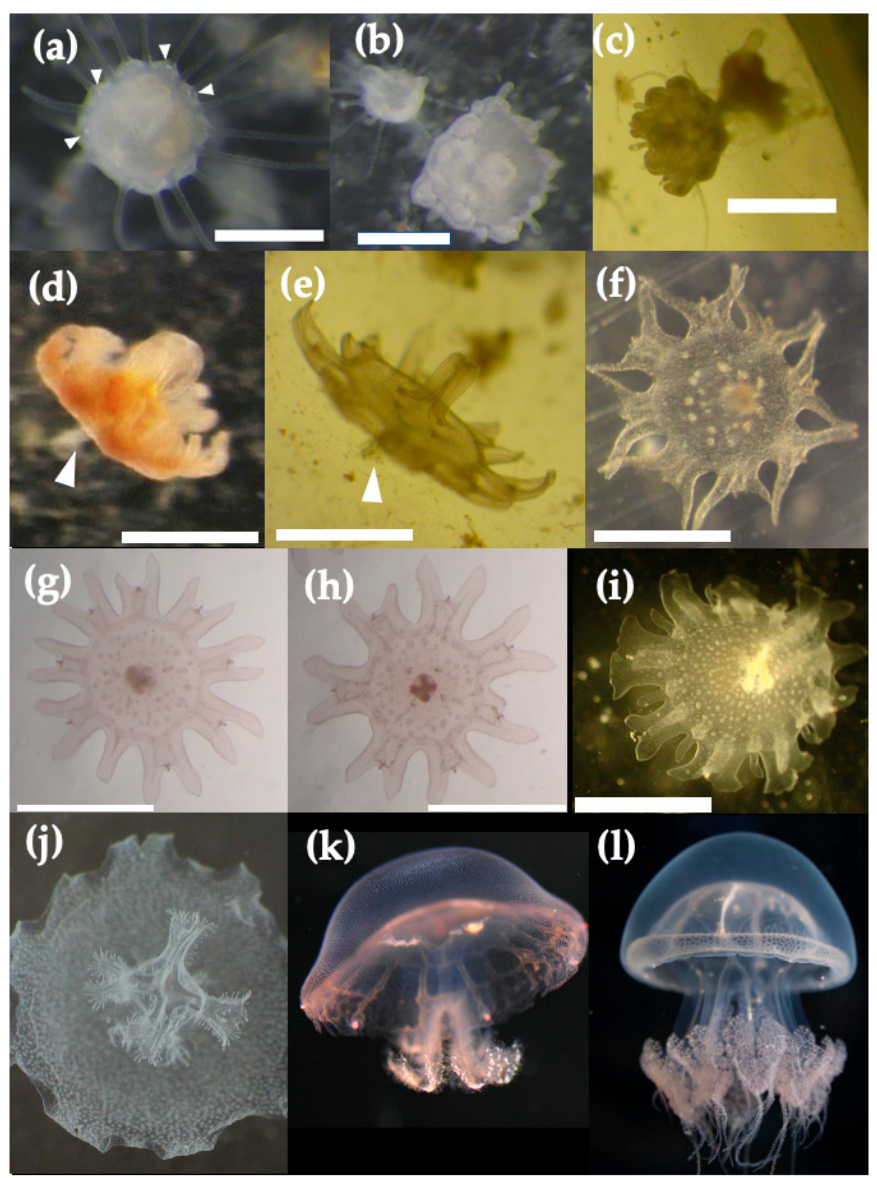
Figure 8. Life stages of Acromitus hardenbergi (strobila to medusa): ( a ) primary stage of strobilation, white arrows show statoliths, scale bar = 500 µ m; ( b ) intermediate stage of strobilation, scale bar = 500 µ m; ( c ) late stage of strobilation, scale bar = 1 mm; ( d , e ) final stage of strobilation, white arrows show tiny residuum, scale bar = 500 µ m; ( f – h ) ephyra, scale bar = 1 mm; ( i ) ephyra (7 days), scale bar = 2 mm; ( j ) metaephyra (20 days); ( k ) juvenile medusa (2 months); ( l ) young medusa. ( a – k ) Breeding individuals, ( l ): wild individual.